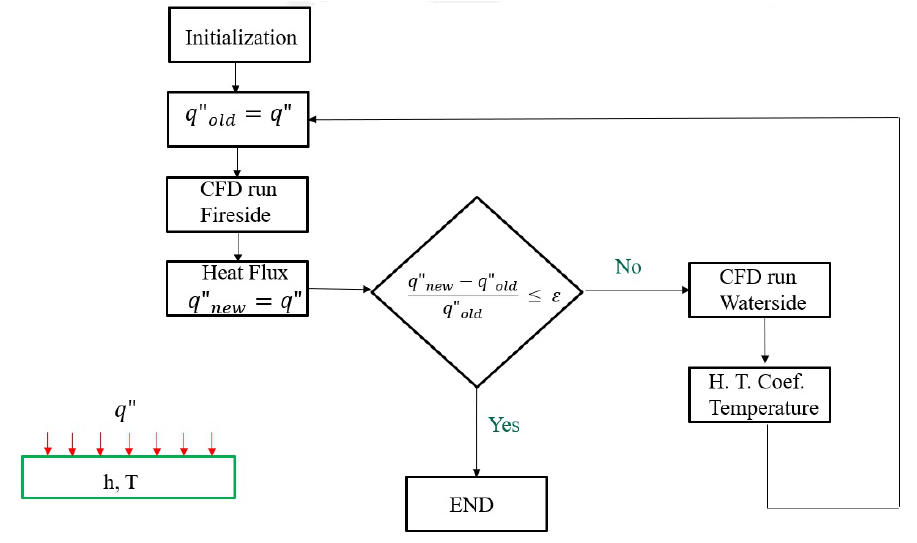
Figure 3. Coupling algorithm between the CFD models.